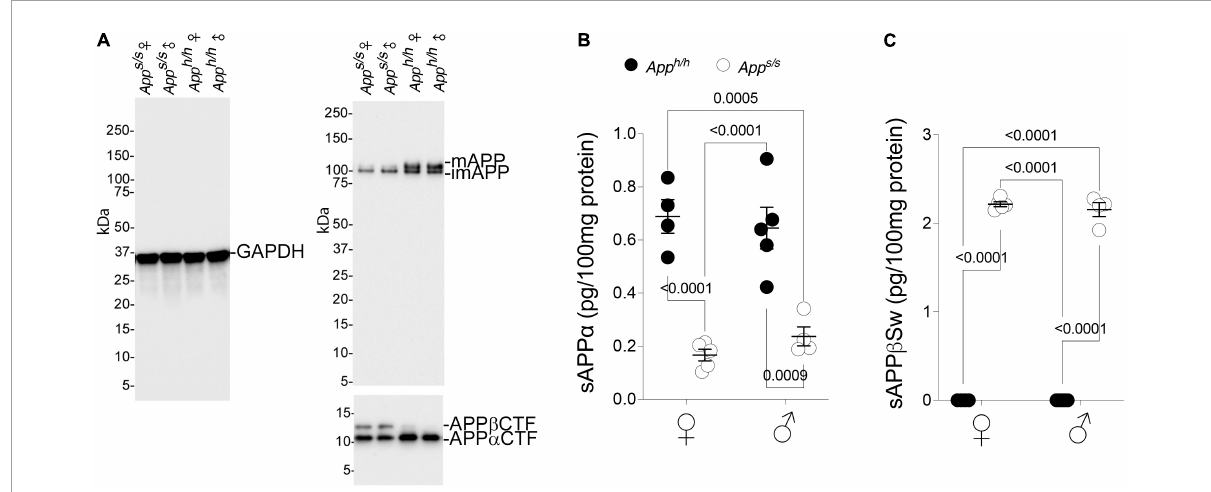
FIGURE4 Increased processing by β -secretase and decreased processing by α -secretase of Swedish APP. (A) Western blot (WB) of brain lysates from App s / s and App h / h rats with an anti-GAPDH antibody (left) and the anti C-terminal APP antibody Y188 (right). A longer exposure was used to visualize the two C-Terminal APP fragments β CTF and α CTF (bottom). The samples analyze contain equal amounts of brain lysates from: App h / h females n = 4, App s / s females n = 5, App h / h males n = 5, App s / s males n = 4. (B) Levels of sAPP α were determined by ELISA ( App h / h females n = 4, App s / s females n = 5, App h / h males n = 5, App s / s males n = 4). Data are represented as mean ± SEM and were analyzed by two–way ANOVA followed by post-hoc Sidak’s multiple comparisons test when ANOVA showed significant differences (sex factor, F ( 1 , 14 ) = 0.05753, P = 0.8139; genotype factor, F ( 1 , 14 ) = 69.01, P < 0.0001; sex × genotype interaction, F ( 1 , 14 ) = 1.037, P = 0.3259; post-hoc Sidak’s multiple comparisons test, female App h / h vs. female App s / s P < 0.0001; female App h / h vs. male App h / h P = 0.9953; female App h / h vs. male App s / s P = 0.0005; female App s / s . vs. male App h / h P < 0.0001; female App s / s . vs. male App s / s P = 0.9478; male App h / h vs. male App s / s P = 0.0009). (C) Levels of sAPP β Sw were determined by ELISA ( App h / h females n = 4, App s / s females n = 5, App h / h males n = 5, App s / s males n = 4). Control samples have no signal because the ELISA does not recognize wild type sAPP β . Data are represented as mean ± SEM and were analyzed by two–way ANOVA followed by post-hoc Sidak’s multiple comparisons test when ANOVA showed significant differences (sex factor, F ( 1 , 14 ) = 0.6506, P = 0.4334; genotype factor, F ( 1 , 14 ) = 3347, P < 0.0001; sex × genotype interaction, F ( 1 , 14 ) = 0.6531, P = 0.4325; post-hoc Sidak’s multiple comparisons test, female App h / h vs. female App s / s P < 0.0001; female App h / h vs. male App h / h P > 0.9999; female App h / h vs. male App s / s P < 0.0001; female App s / s .